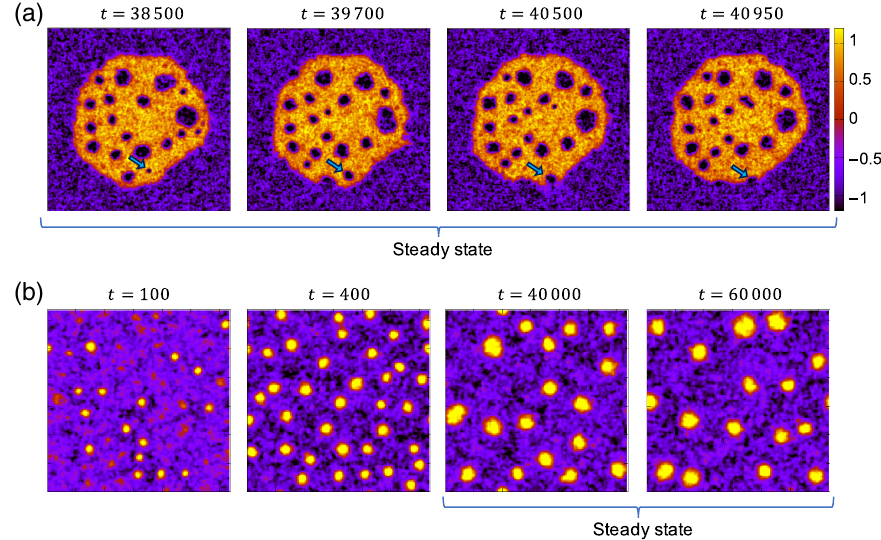
FIG. 1. (a) Bubbly phase separation as described in our field theory, a phase coexistence of boiling liquid (yellow) with a vapor phase (blue). Vapor bubbles are continuously created inside the bulk liquid phase, which are then expelled to the exterior vapor phase (indicated by a blue arrow in the figure, also see Movie 4 in Ref. [36]). The vapor phase can then diffuse back inside the liquid, and the process continues indefinitely. Time-reversal symmetry is manifestly broken in this steady state. (b) Arrested phase separation: Initially, the system phase separates into a dense phase and a dilute phase. However, the average cluster size saturates to a finite value at a steady state. Additional steady states, representing (a) a cluster phase in coexistence with excess dense liquid and (b) a strict bubble phase, are found by inverting the order parameter scale shown the top right, as it follows from the invariance of the model under the duality mapping explained in Sec. II. The parameters we use are ζ ¼ 4 , λ ¼ 1 , ϕ 0 ¼ − 0 . 4 in (a) and ζ ¼ − 4 , λ ¼ − 1 , ϕ 0 ¼ − 0 . 6 in